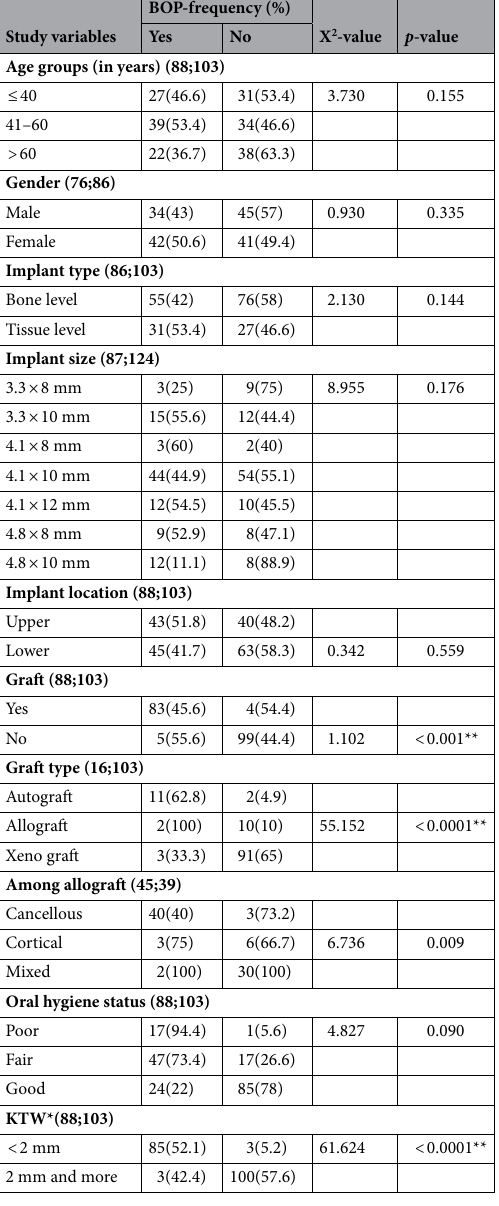
Table 3. Association between BOP and other study variables. *Keratinized tissue width. **Statistically